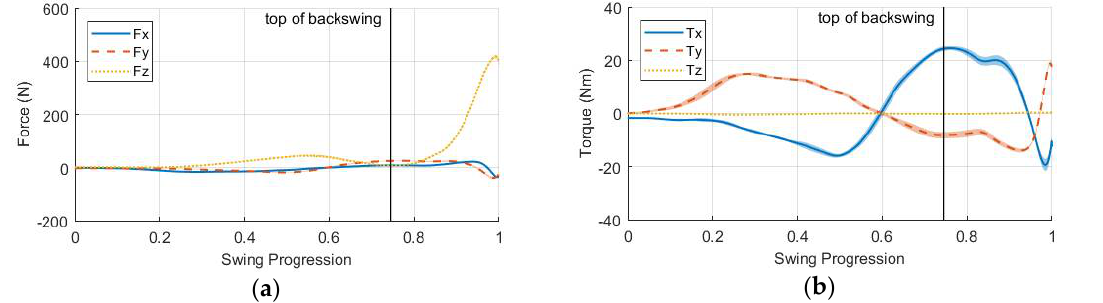
Figure 3. ( a ) Golfer A grip forces; ( b ) Golfer A grip torques. Provided in the grip reference frame.